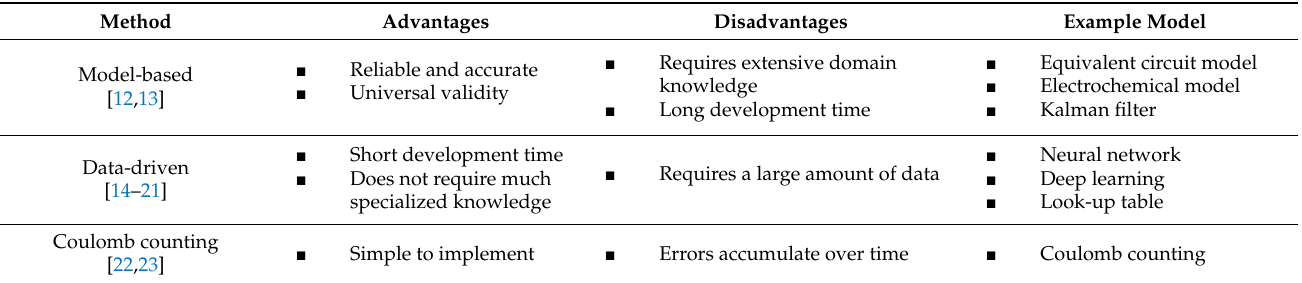
Table 1. Advantages and disadvantages of model-based, data-driven, and coulomb-counting